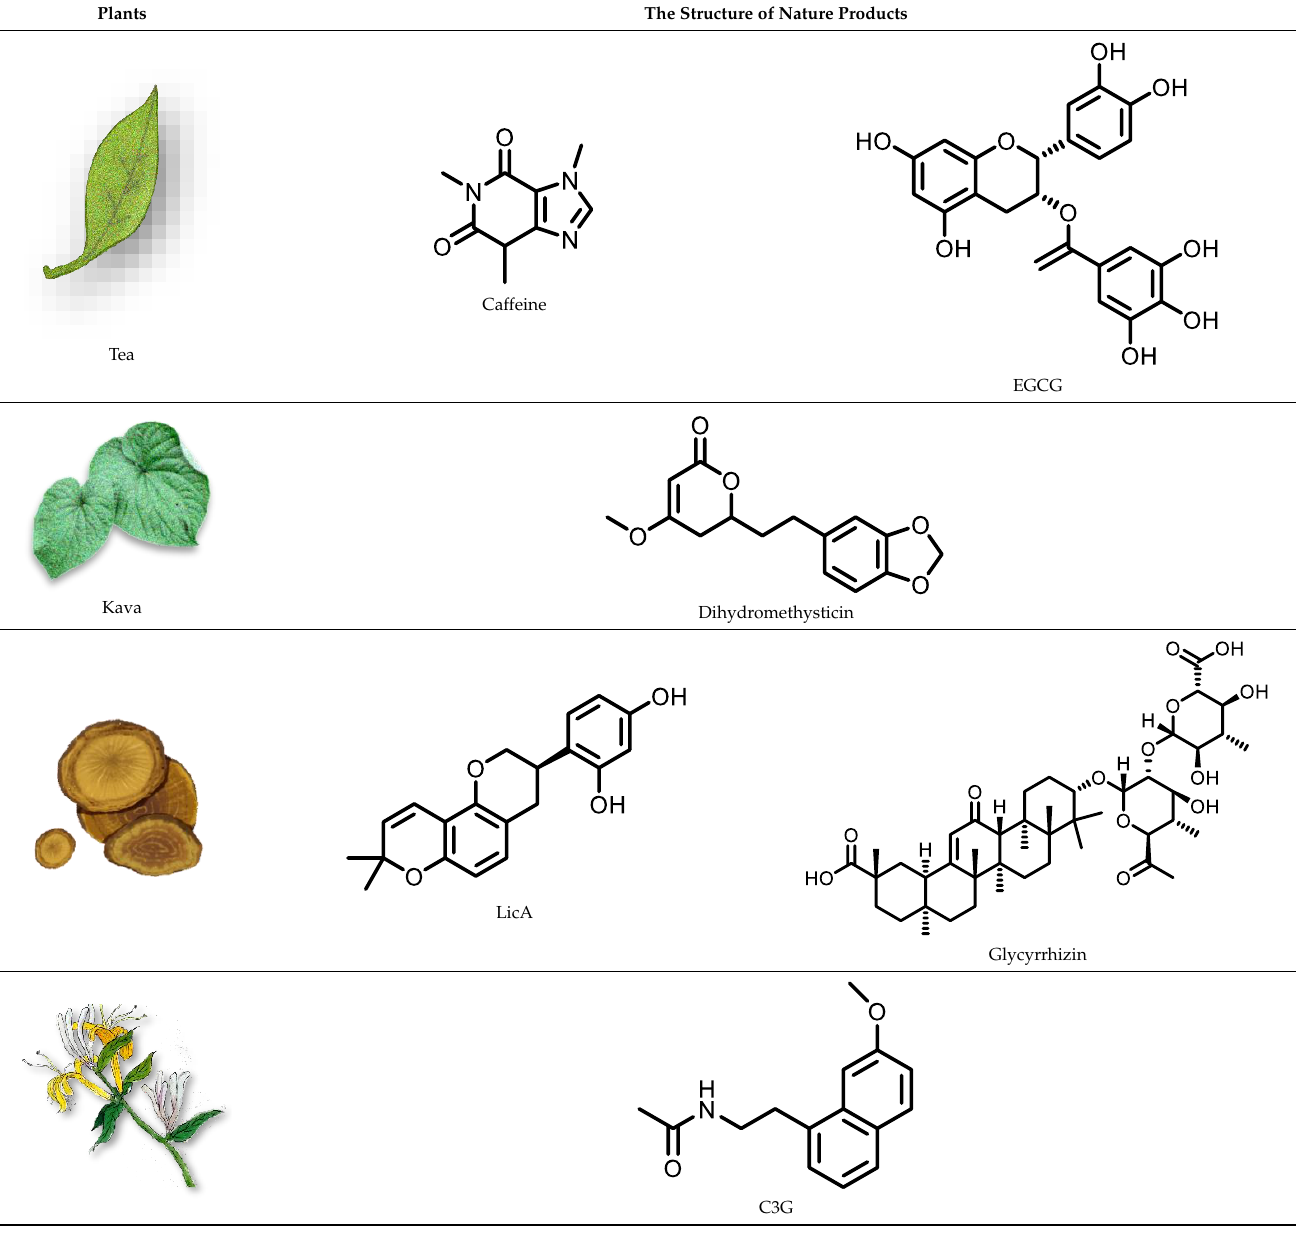
Table 3. The representative dietary plants and phytochemicals for lung cancer prevention.